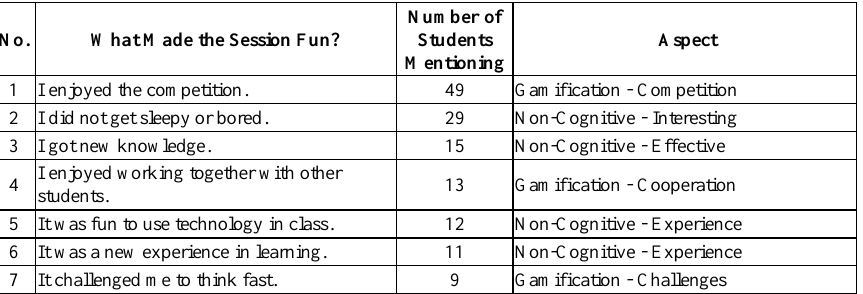
Table 7. Questionnaire Result, Part 3, Question